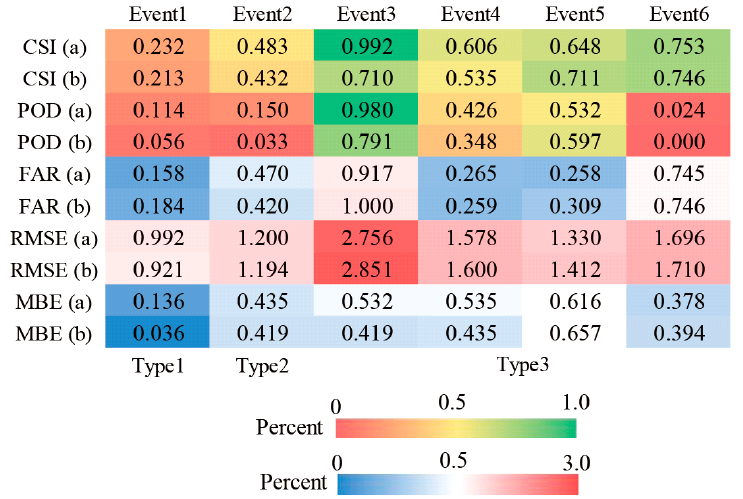
Figure 3. Evaluation values of the indices for the temporal rainfall distribution of the six storm events: ( a ) WRF-only; ( b ) the fully coupled WRF/WRF-Hydro.